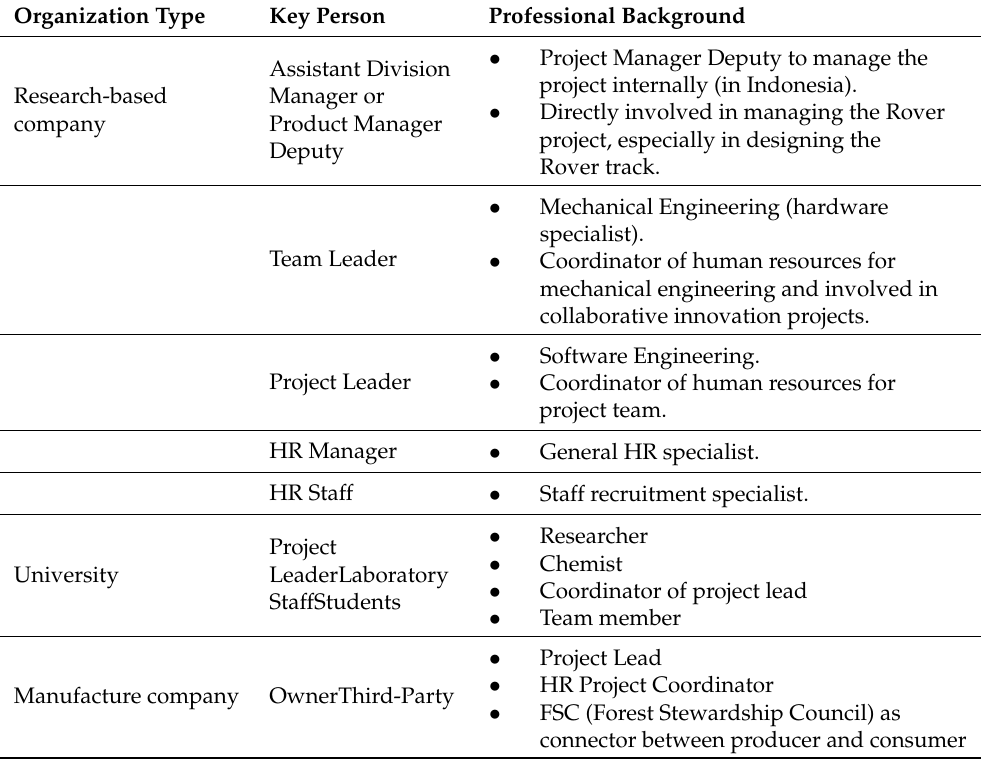
Table 1. Profile of key informants.